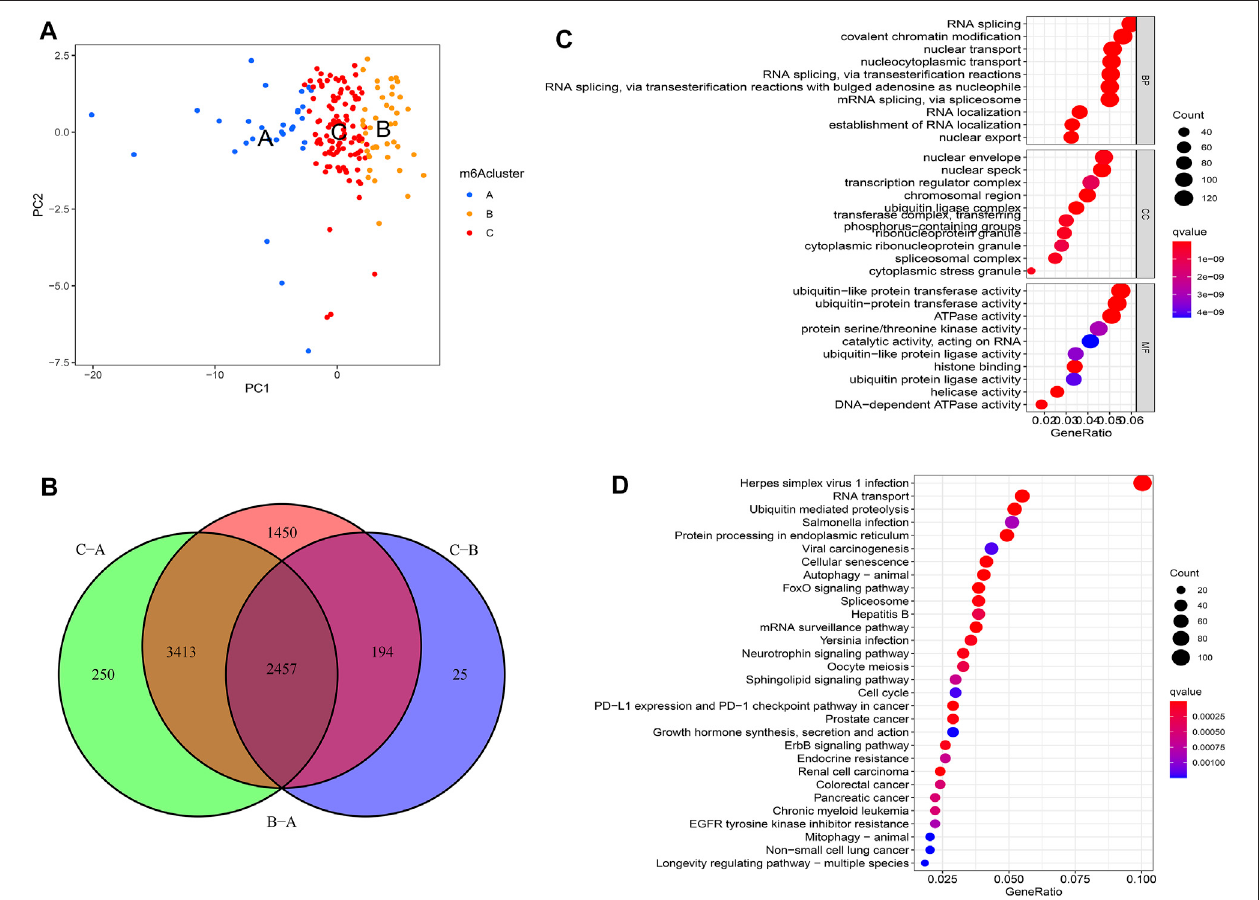
FIGURE 4| Molecular characteristics ofdifferentially expressed genes (DEGs) among m6Aclusters. (A) PCA among distinctm6Aclusters; (B) The DEGs extracted between three m6A clusters; (C) GO enrichment analysis for the DEGs; (D) KEGG pathway analysis for the DEGs.